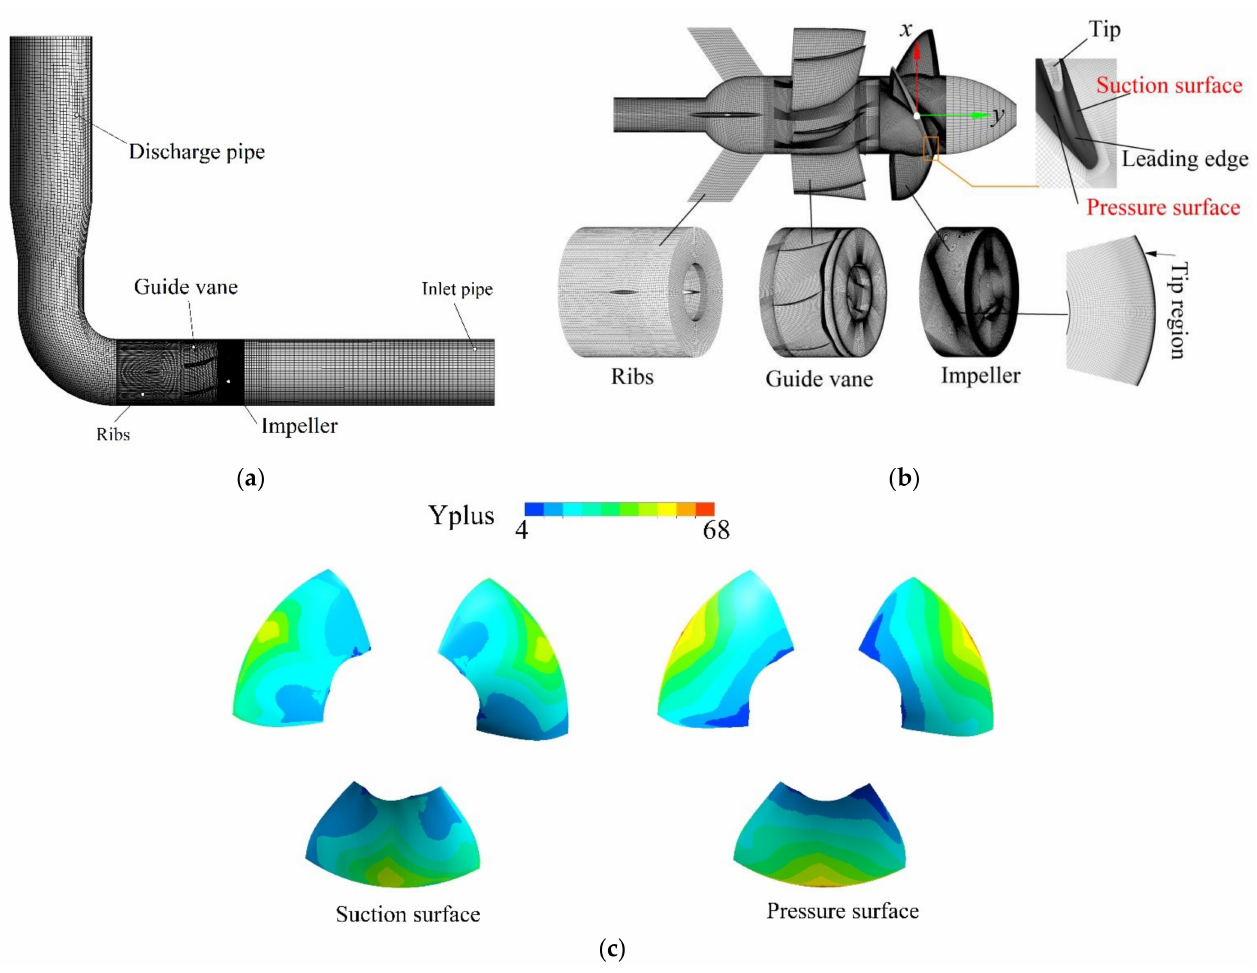
Figure 2. Mesh of the axial-flow pump and Y + distribution. ( a ) Mesh of computational domain; ( b ) Mesh of main components; ( c ) Y + distributions on the blade